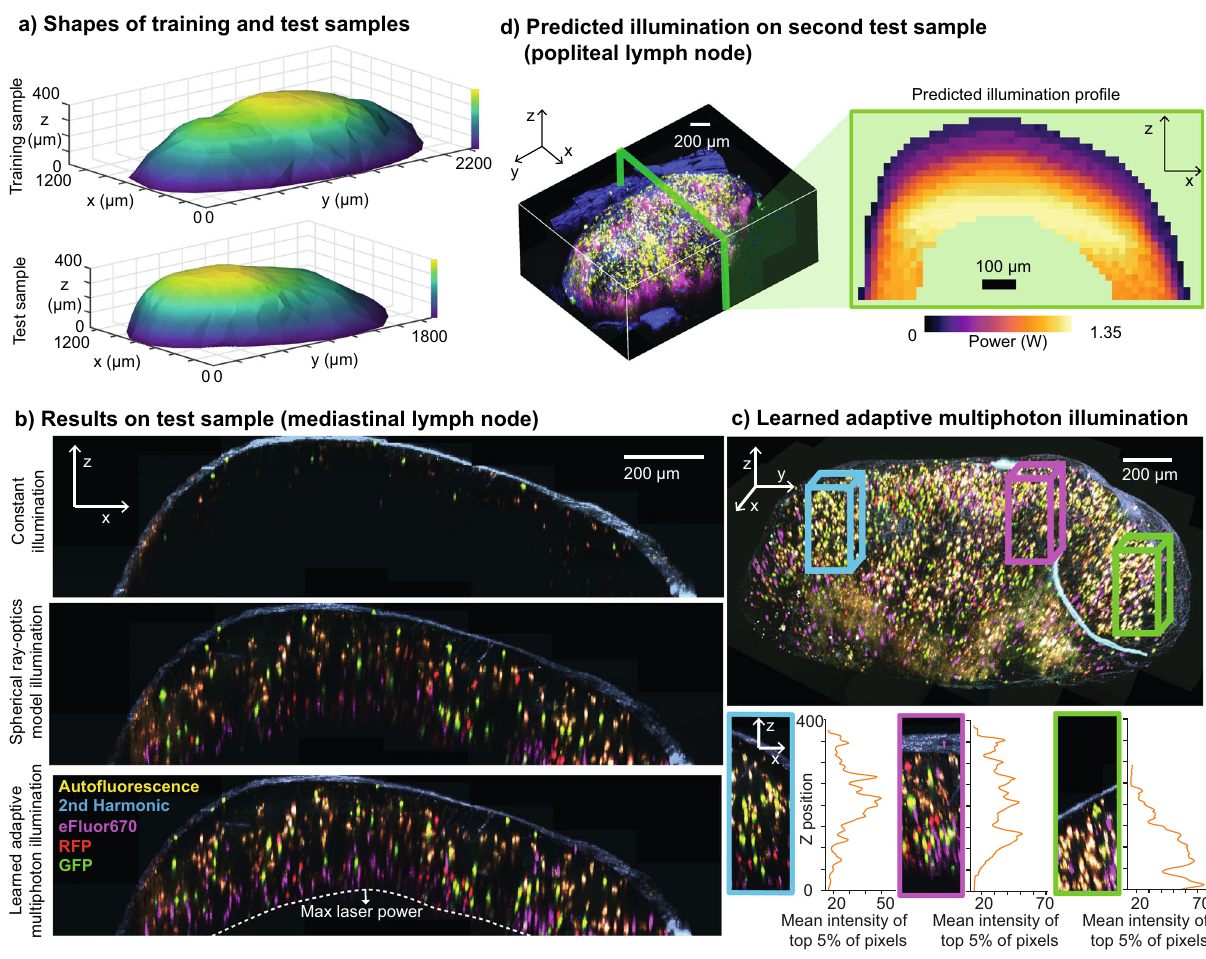
Fig. 2 Validation of LAMI on lymph node samples. a The surface shapes of lymph nodes used for (top) training with standard candles and (bottom) testing. b Results with constant illumination power, illumination power predicted by the ray optics model that assumed a perfectly spherical shape, and illumination power predicted by LAMI in the test sample, which had been seeded with lymphocytes labeled with GFP (green), RFP (red), and eFluor670 (magenta). Constant illumination rapidly attenuates the signal with depth. The ray optics model generates contrast throughout the volume, but has visible non-uniformity and areas where the signal from cells is entirely missing. In contrast, LAMI gives good signal throughout the imaging volume up to the maximum excitation laser power. c A 3D view of the LAMI-imaged lymph node, with several XZ projections of representative areas with different surface curvature. Plots show Z-position vs mean intensity of top 5% of pixels to demonstrate good signal is maintained with depth using LAMI. d Popliteal lymph node imaged with LAMI along with XZ cross-section of predicted